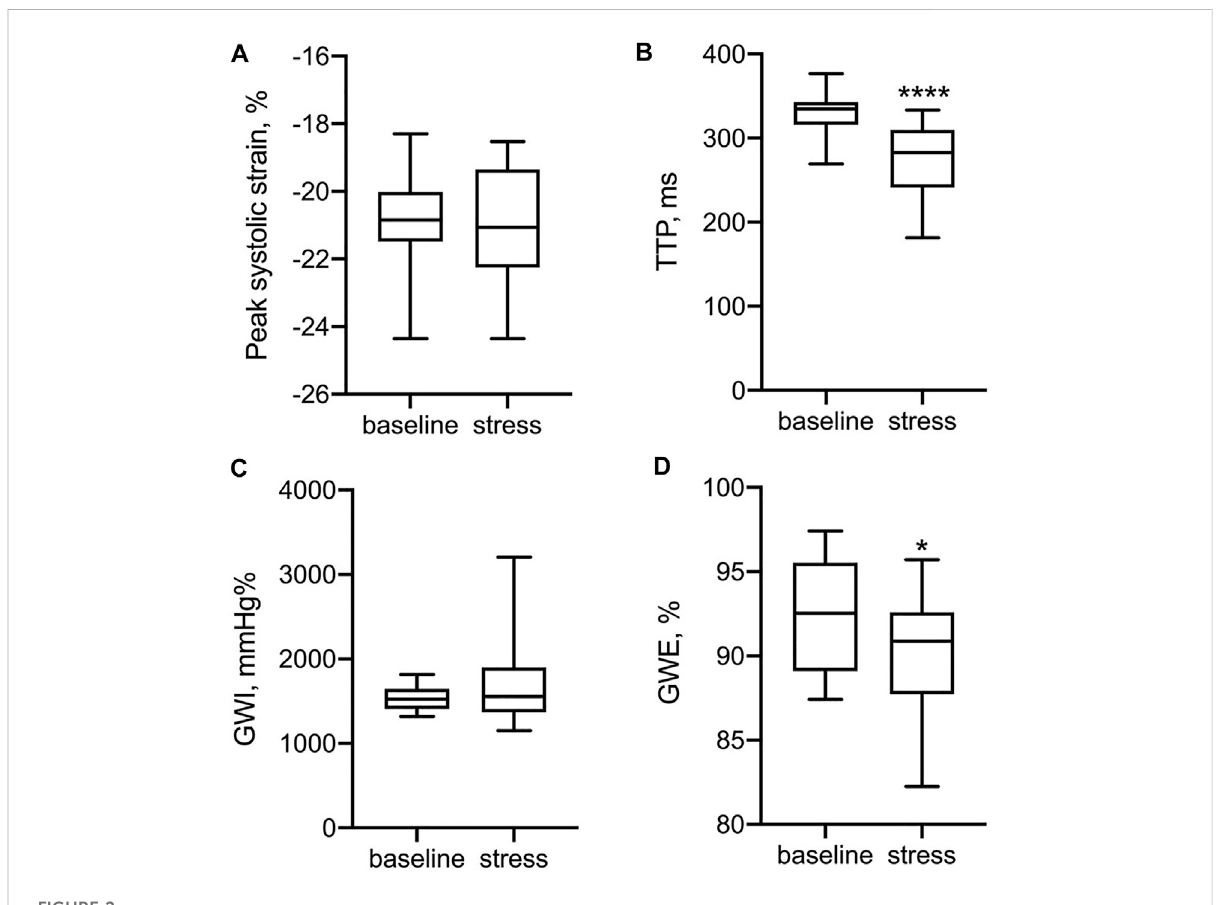
FIGURE 2 Comparison of LV functional parameters between baseline and stress